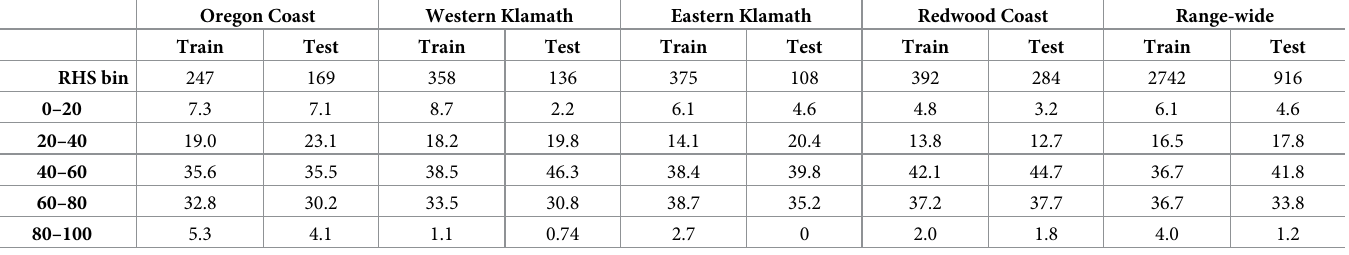
Table 7. Comparison of percentage of northern spotted owl site center locations from 1996 training sites versus independent test sites from 2006 among five rela- tive habitat suitability (RHS) bins for four modeling